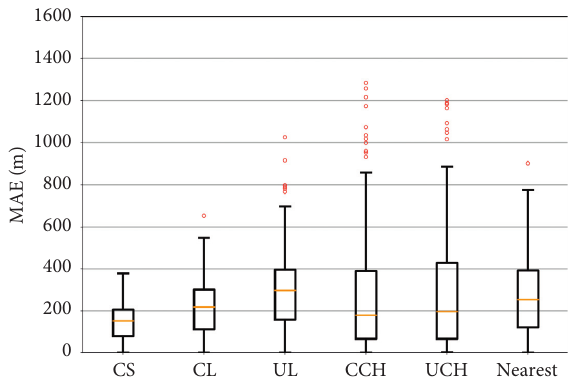
Figure 10: Boxplot of absolute errors of estimated points.